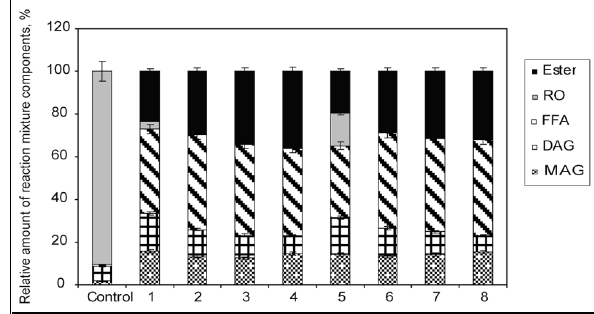
Fig. 2. The effect of reaction time and type of alcohol used (methanol, columns 1–4, 1-butanol, columns 5–8) on Lipoprime 50T-catalyzed rapeseed oil transesterification effectiveness. Control – RO. Quantitative analysis (%) was performed using the Micro image 4.0 programme. Reaction was performed in o C after: 1 h – column 1; 15 h – column 2; 1 h t -butanol at 37 after addition of extra amount of methanol – column 3; 11 h after addition of extra amount of methanol – column 4; 1 h – column 5; 15 h – column 6; 1 h after addition of extra amount of 1-butanol – column 7; 11 h after addition of extra amount of 1-butanol –column 8.